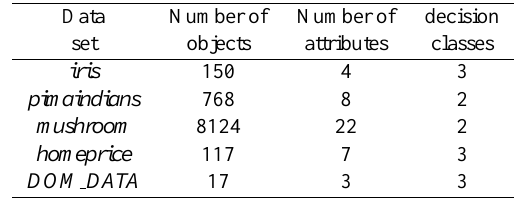
Table 2. Characteristics of real data sets used for experiments.